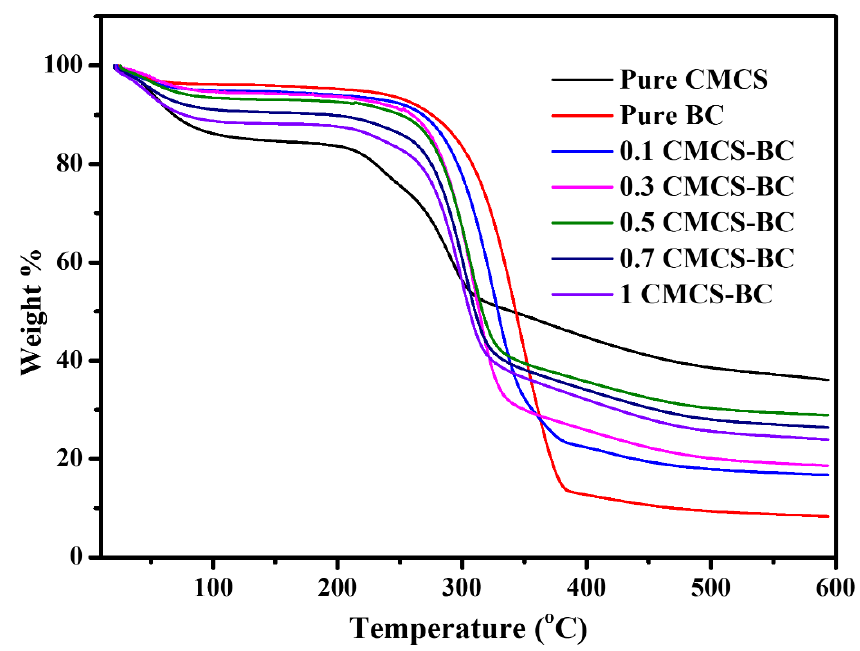
Figure 2. TG–DTA curves of pure BC, CMCS, and CMCS–BC hydrogels. Figure 3 displayed the morphology of freeze-dried pure BC and CMCS–BC hydro-